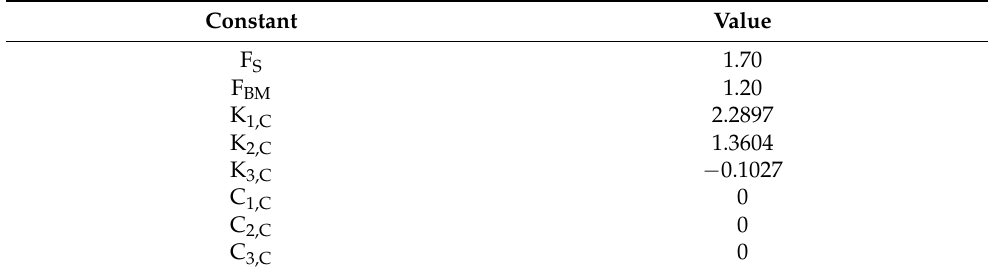
Table 3. Values of constants for estimating the capital cost of the compressor